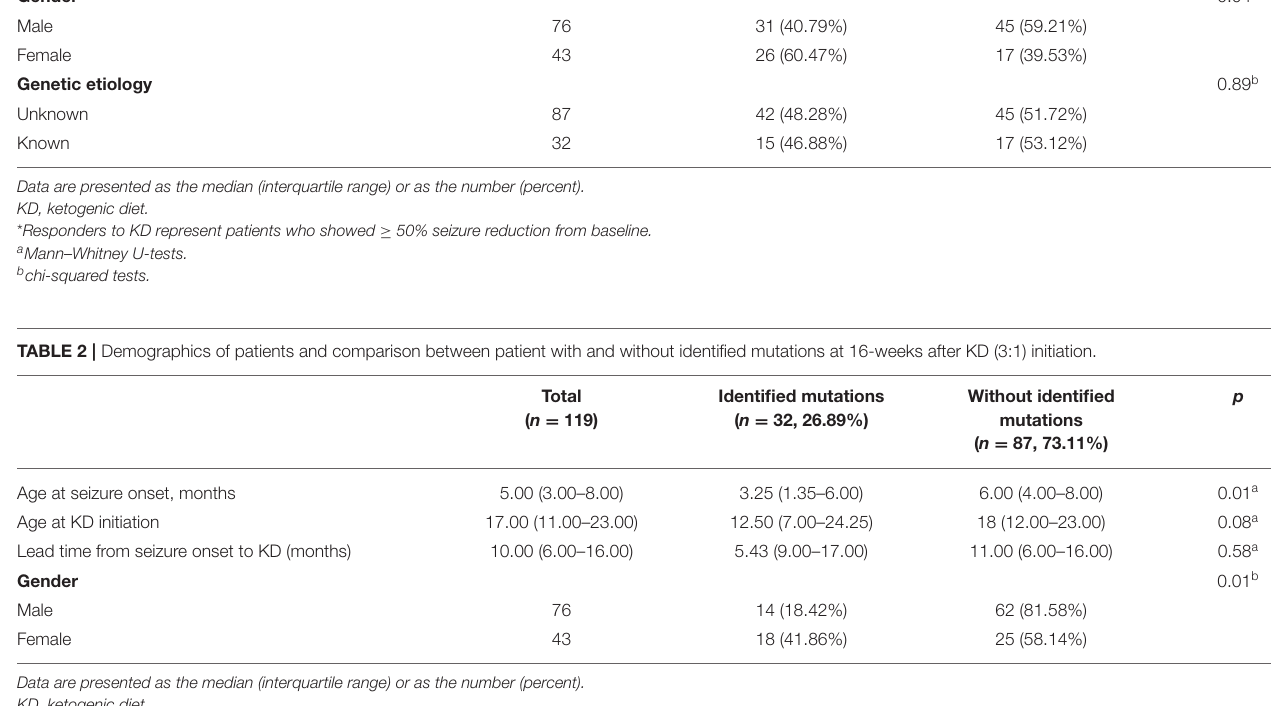
Data are presented as the median (interquartile range) or as the number (percent). KD, ketogenic